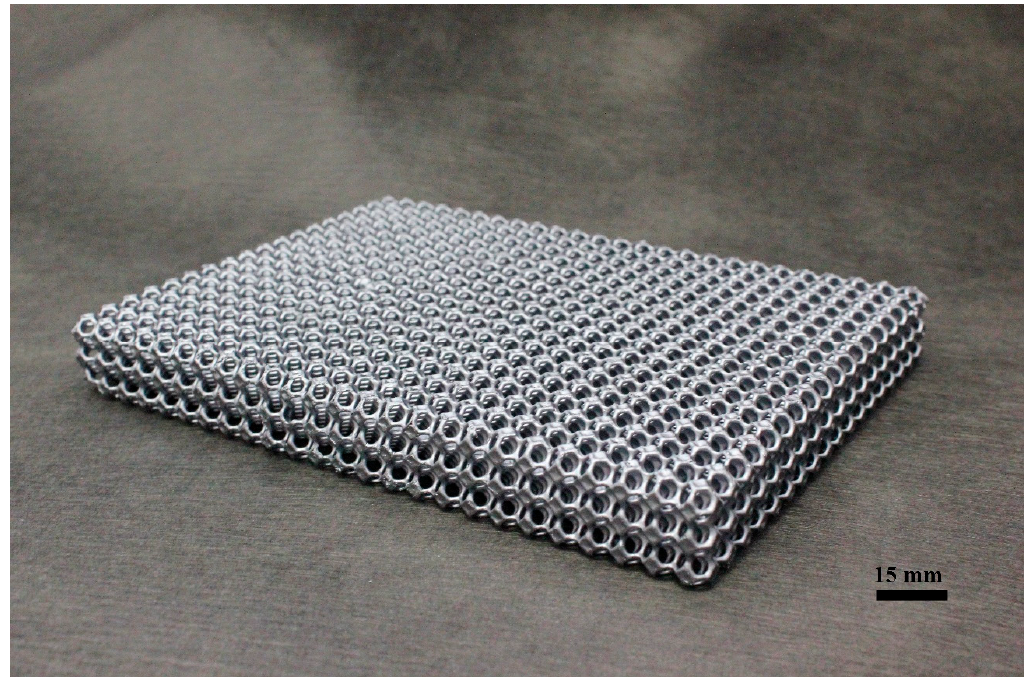
Figure 6. SiSiC lattice fabricated with replica method.